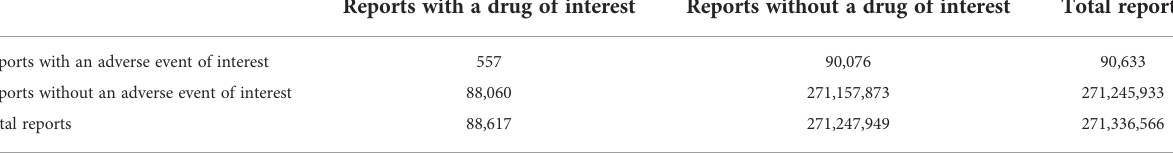
TABLE 2 Two-by-two contingency table for report collection and database